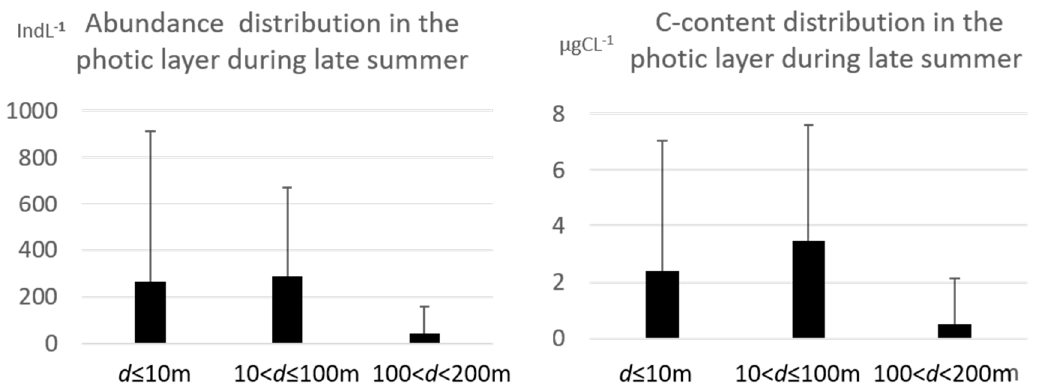
Figure 4. Average abundance distribution of tintinnids (indL − 1 ) and carbon content ( µ gCL − 1 ) in the three layers defined in the photic zone (<200 m); bars represent standard deviation ( sd ); d ≤ 10 m, n = 99; 10 < d ≤ 100 m, n = 74; 100 < d < 200 m, n = 99.